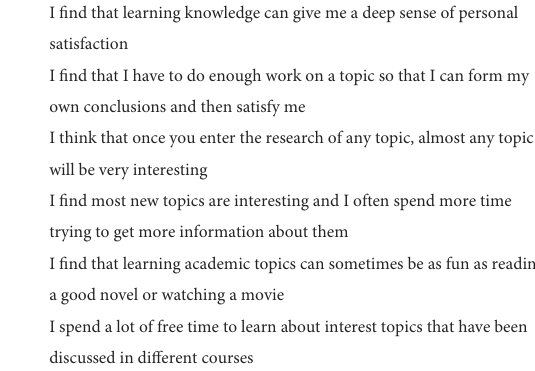
TABLE 3 Perceived usefulness and ease of use scale.